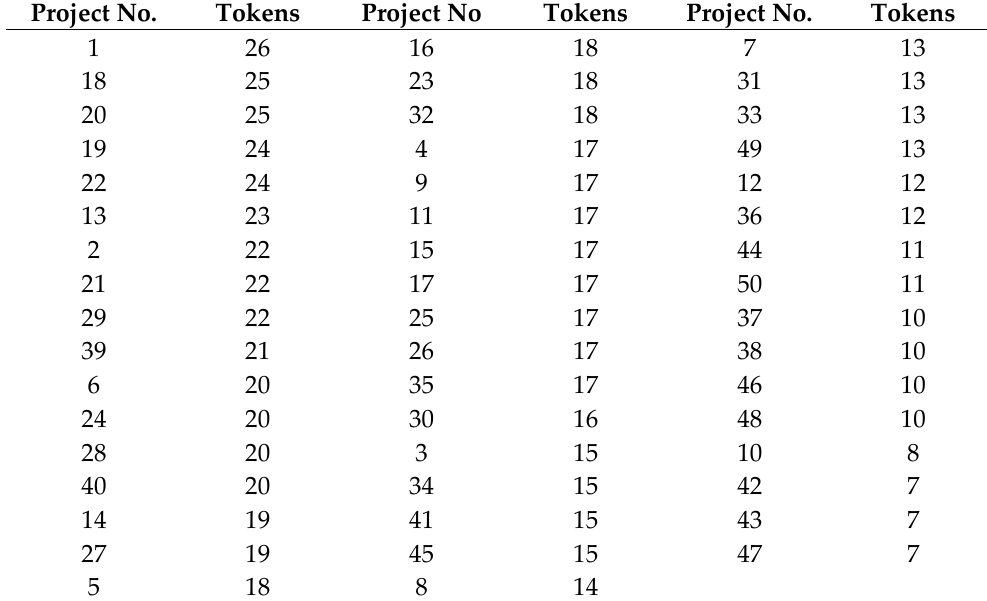
Table 1. The research items listed with the token counts.